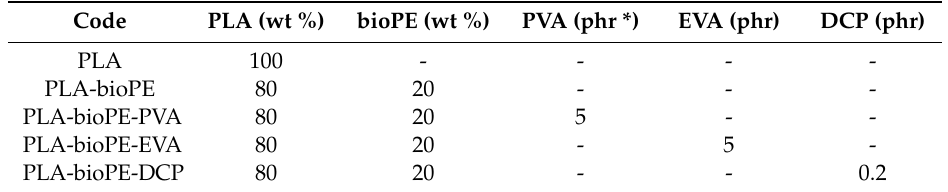
Table1. Codeandcompositionofuncompatibilizedandcompatibilizedpolylactide / biobasedhigh-density polyethylene (PLA / bioPE)